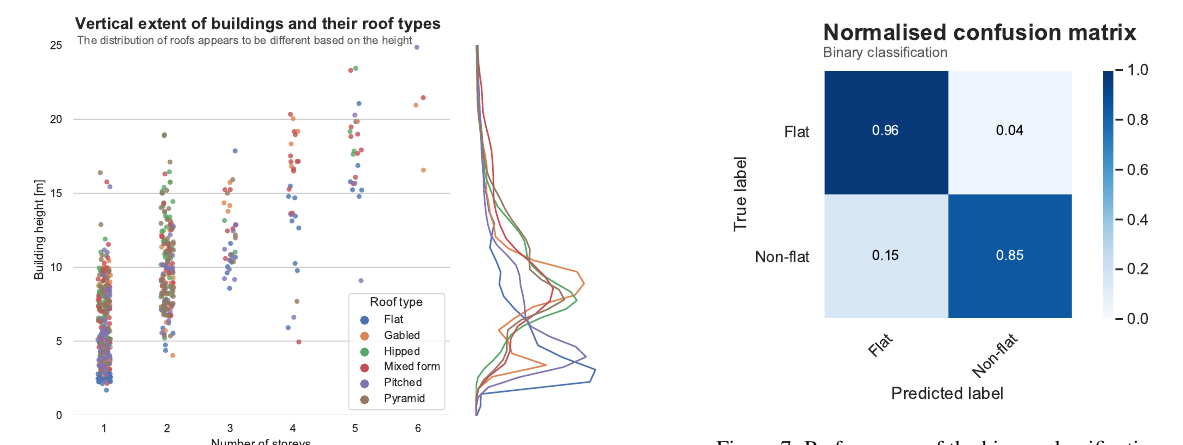
Figure 7. Performance of the binary classification.